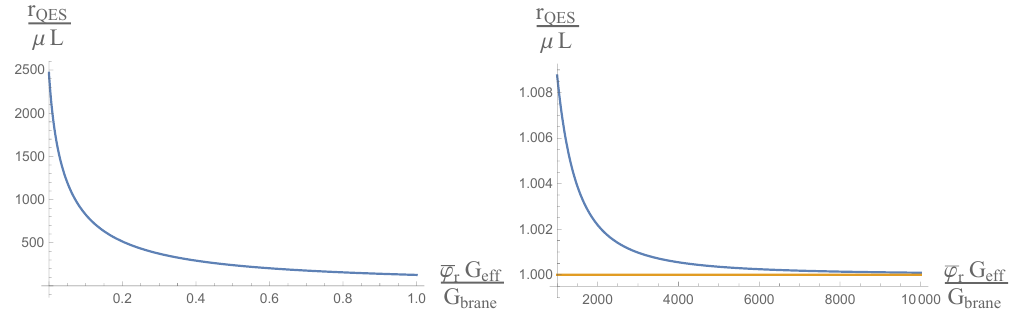
Figure 5 . Change in the radial position of the quantum extremal surface for R = 0 . 4 and the same base parameters as in figure 4. As shown in the text, r QES to ¯ ϕ r G eff for ¯ ϕ r G eff . k and asymptotes very close to the horizon for larger values of ¯ ϕ r G eff G brane G brane